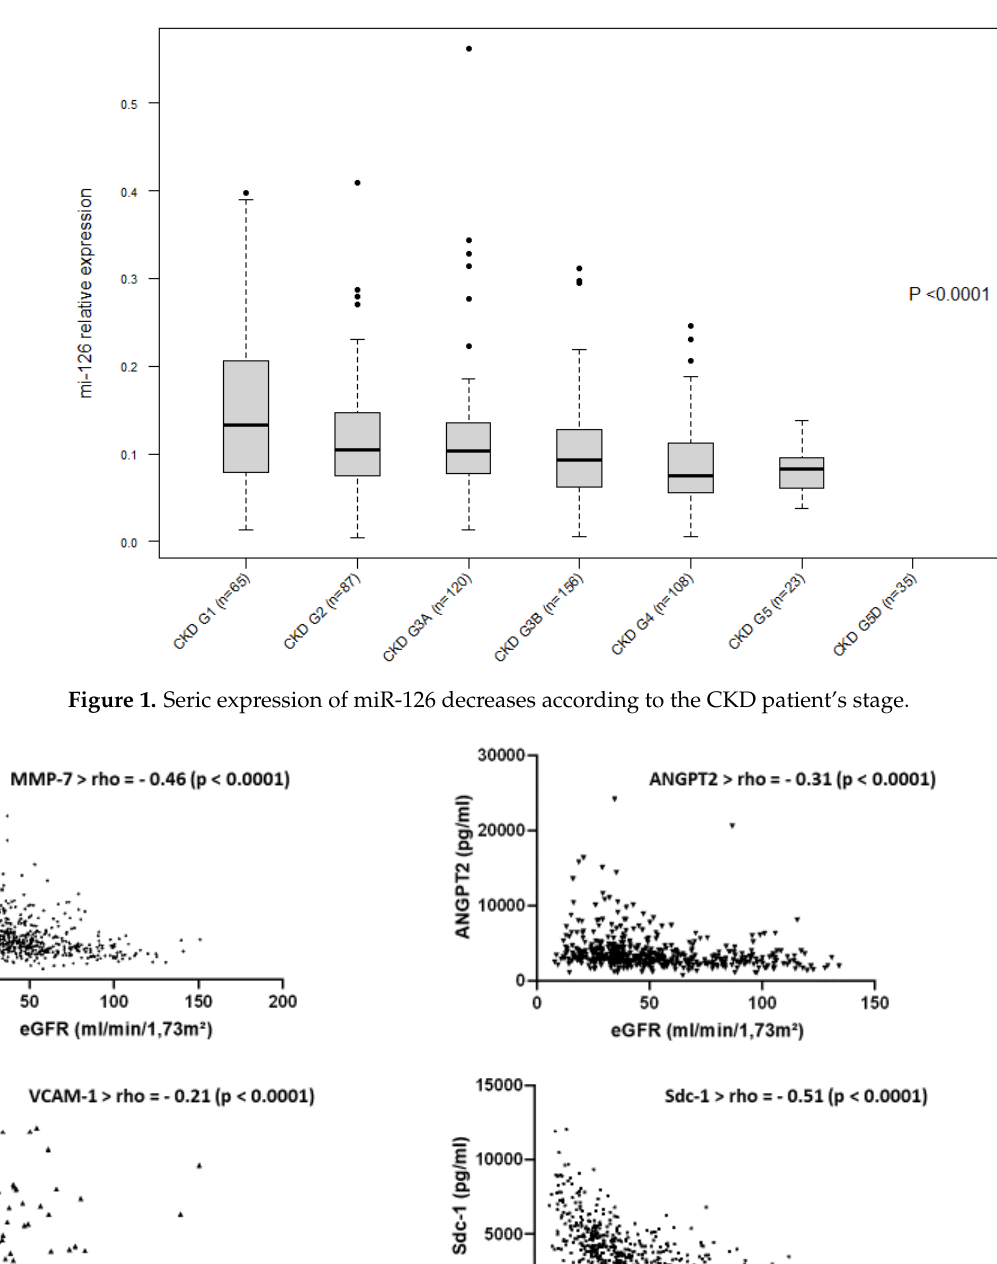
Table 1. Association of miR-126 with endothelial markers using univariate analysis.